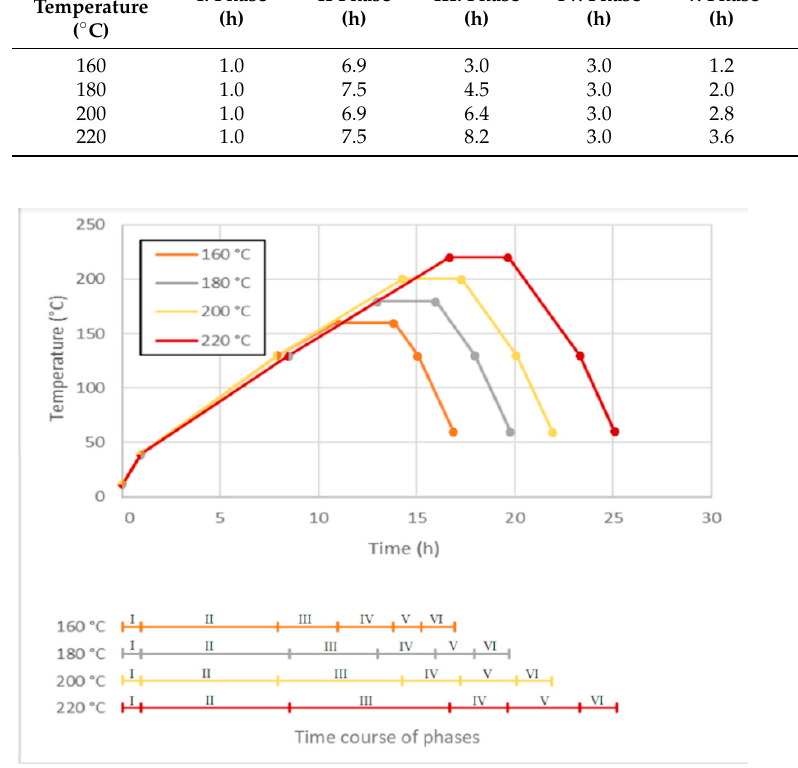
Figure 1. Course of the thermal modification of samples used in the experiment [25]. After heat treatment, 40 × 40 × 10 mm samples were cut from planks, five for each final temperature. Five control samples were cut from an untreated plank. These samples were used for the measurement of the heat transfer coefficient with the use of holographic interferometry. Samples are shown in Figure 2.